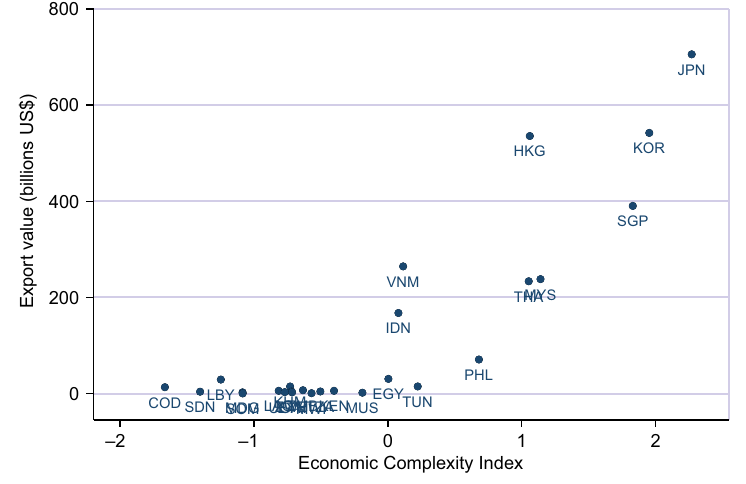
Figure 1. The relationship between ECI and Export Performance in 2019 (source: UN COMTRADE, 2021; Observatory of Economic Complexity [OEC],